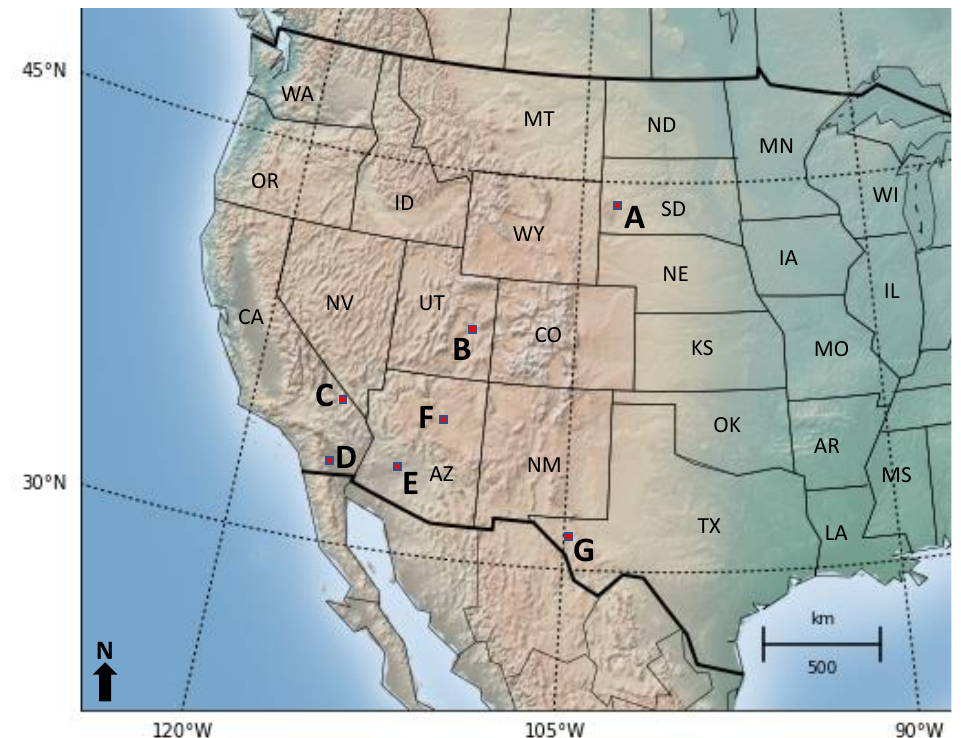
Figure 2. Map of the Western United States showing the locations of the 55 locations picked as part of bare soil regression validation dataset in this study. Data were chosen from USGS sites in sub-regions A-G (indicated with red squares), with the specific locations in each sub-region shown in Figure 3.